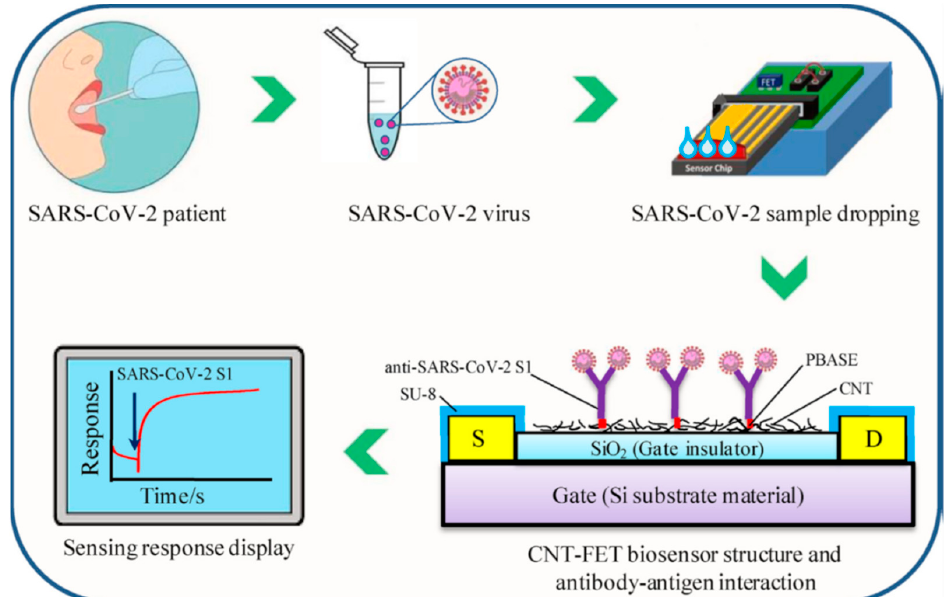
Figure 12. Schematic illustration of SARS-CoV-2 S1 testing steps of CNT-FET biosensor. Anti-SARS- CoV-2 S1 was conjugated on the CNT (using PBASE as a linker) to produce SARS-CoV-2 S1 detectable CNT-FET biosensor. Image reproduced with permission from [28]. Copyright 2021 Elsevier.